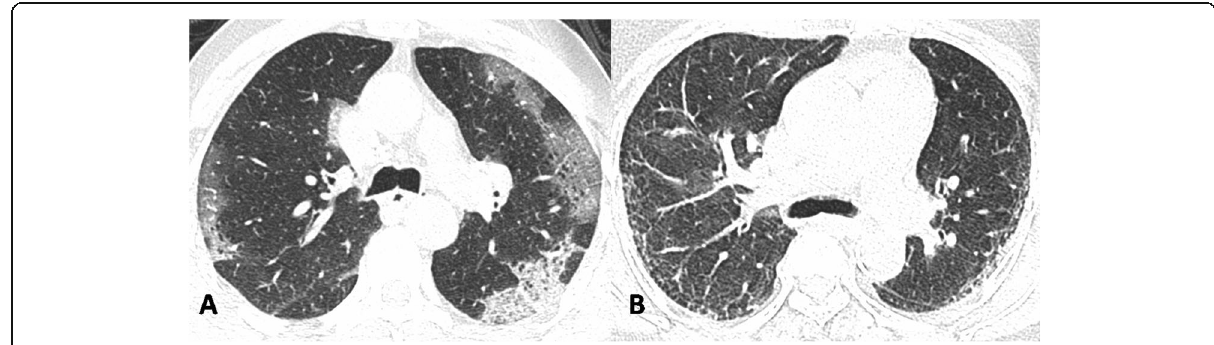
Fig. 4 Axial chest CT image in lung window settings of a 51-year-old COVID-19 patient at the level of carina obtained at admission reveals elongated GGOs in the subpleural lung ( a ). Follow-up CT performed 107 days later reveals residual faint GGOs with interlobular septal thickening in the subpleural lung ( b